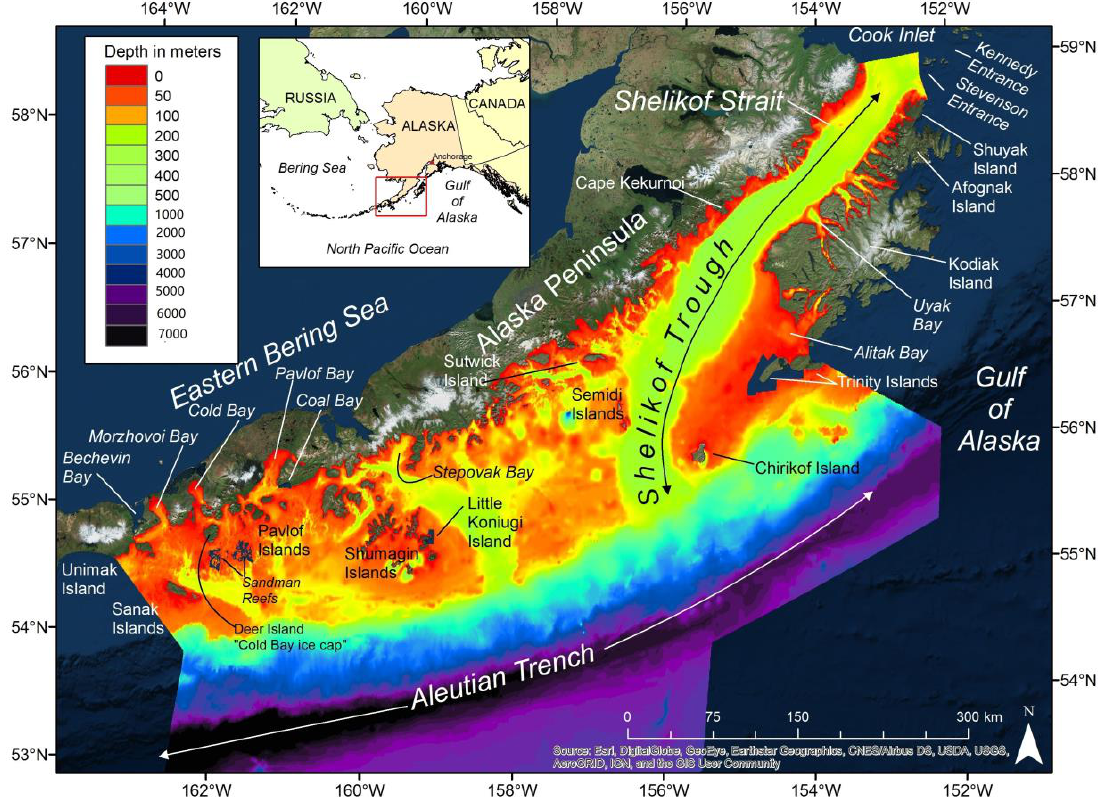
Figure 1. Overview map of the western Gulf of Alaska study area. GEBCO (General Bathymetric Chart of the Oceans) bathymetry is shown for comparative purposes.